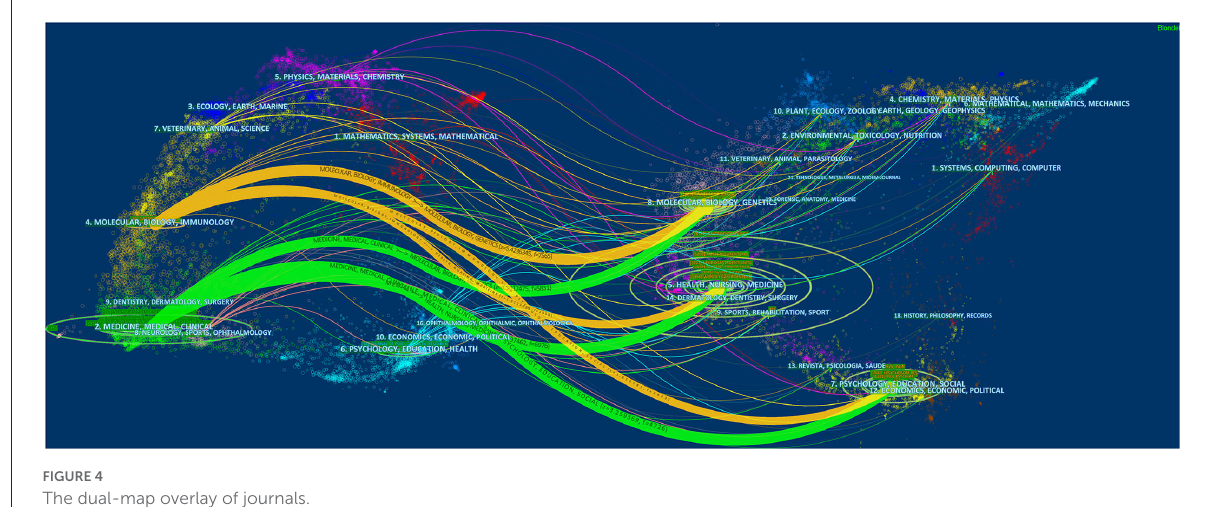
FIGURE4 The dual-map overlay of journals.